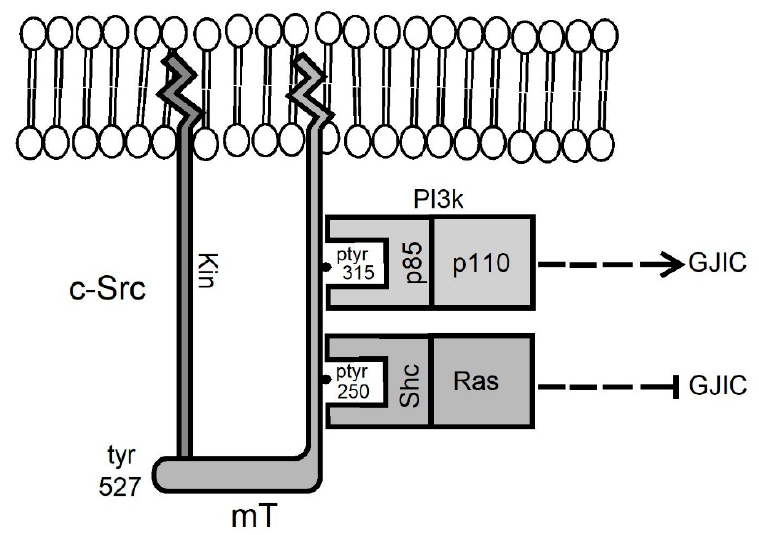
Figure 2. Model of the effect of the Ras/Erk vs. the PI3k/Akt pathways. mT binds to, activates and is phosphorylated by Src family kinases. The mT-pY 250 site binds the Shc adaptor which triggers activation of the Ras/Erk pathway, leading to GJIC suppression. The mT-pY 315 site binds the p85 regulatory subunit of PI3k, triggering activation of Akt, leading to GJIC increase. Upon wt-mT expression the Ras pathway prevails with elimination of communication as a result. Interestingly, neoplastic transformation by mT requires both pathways. Not shown: mT-pY 322 activates PLC γ and PKC, which suppresses GJIC.